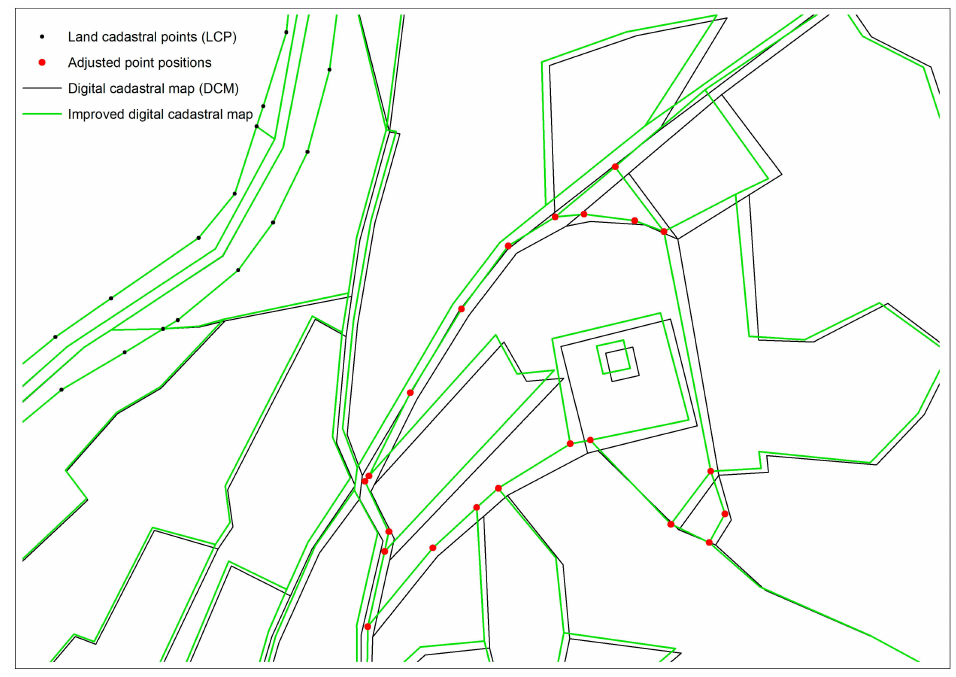
Figure 3. Presentation of fading out e ff ect of proximity fitting of the subject